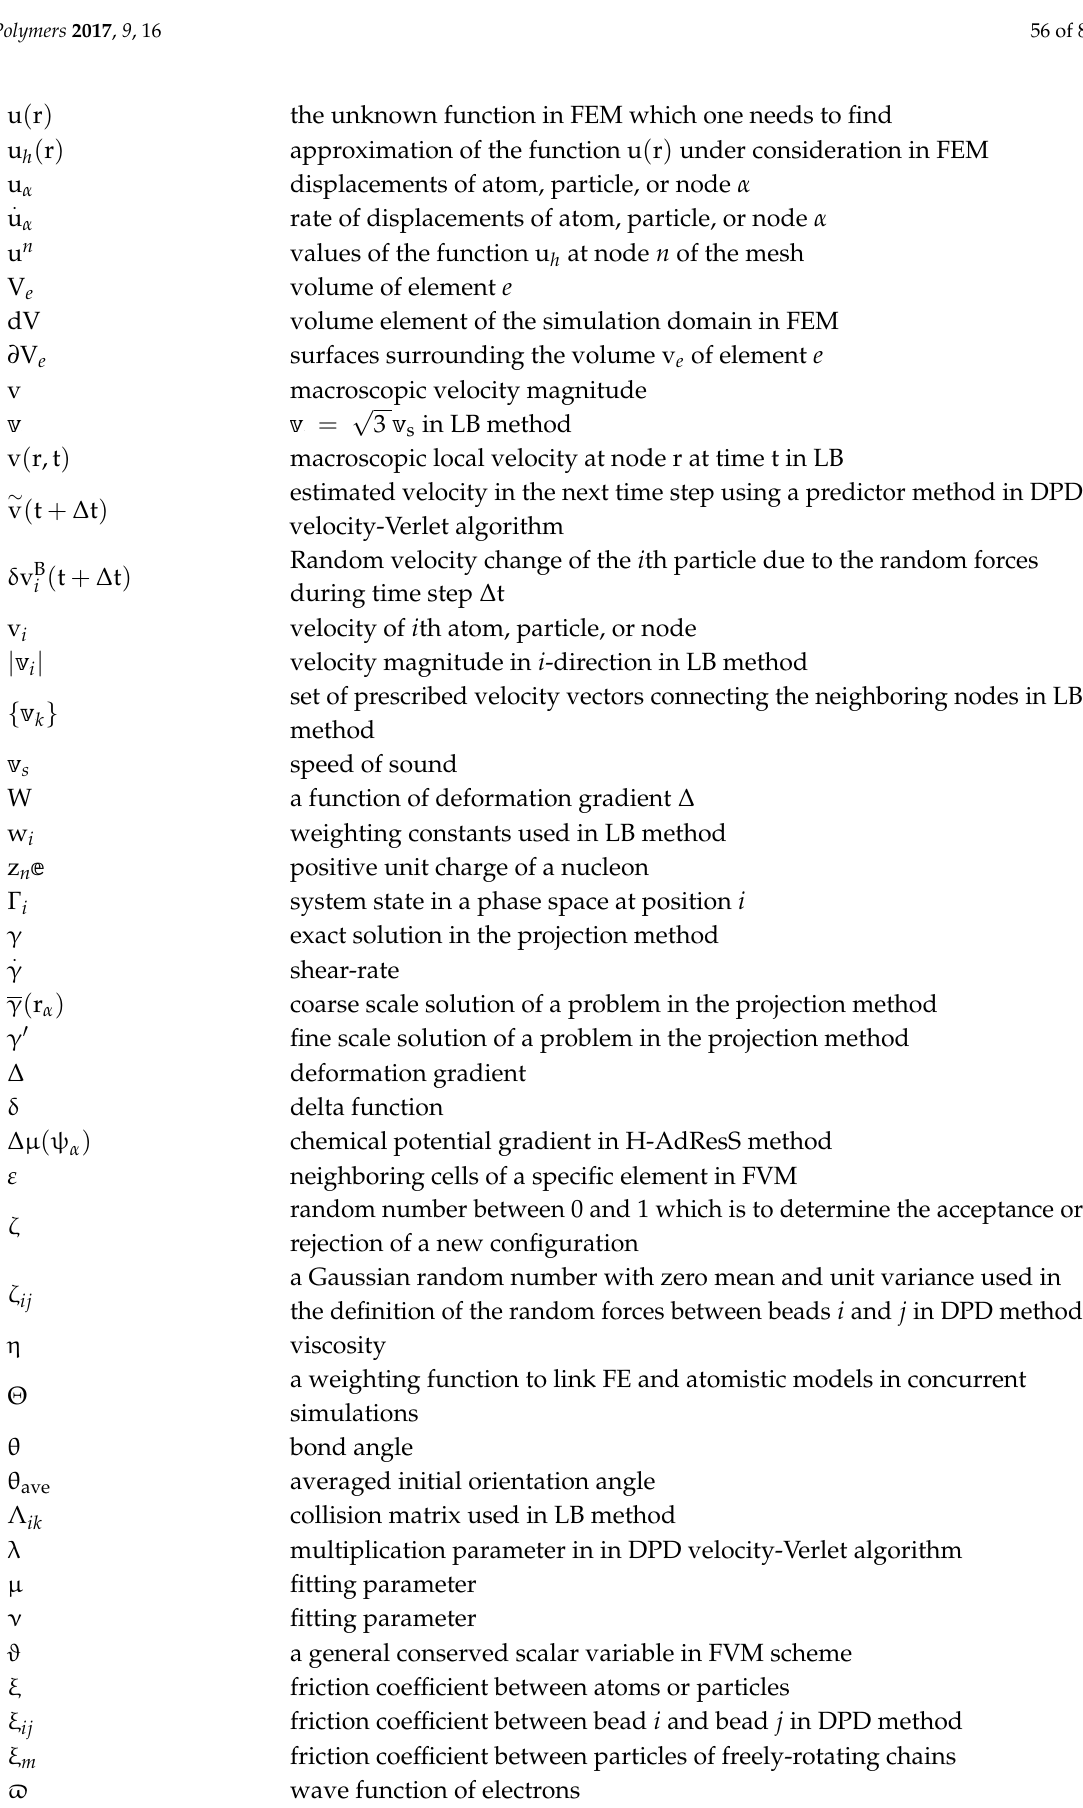
Figure 1. Two typical lattices often used in LB simulations: ( a ) D2Q9; and ( b ) D3Q19.